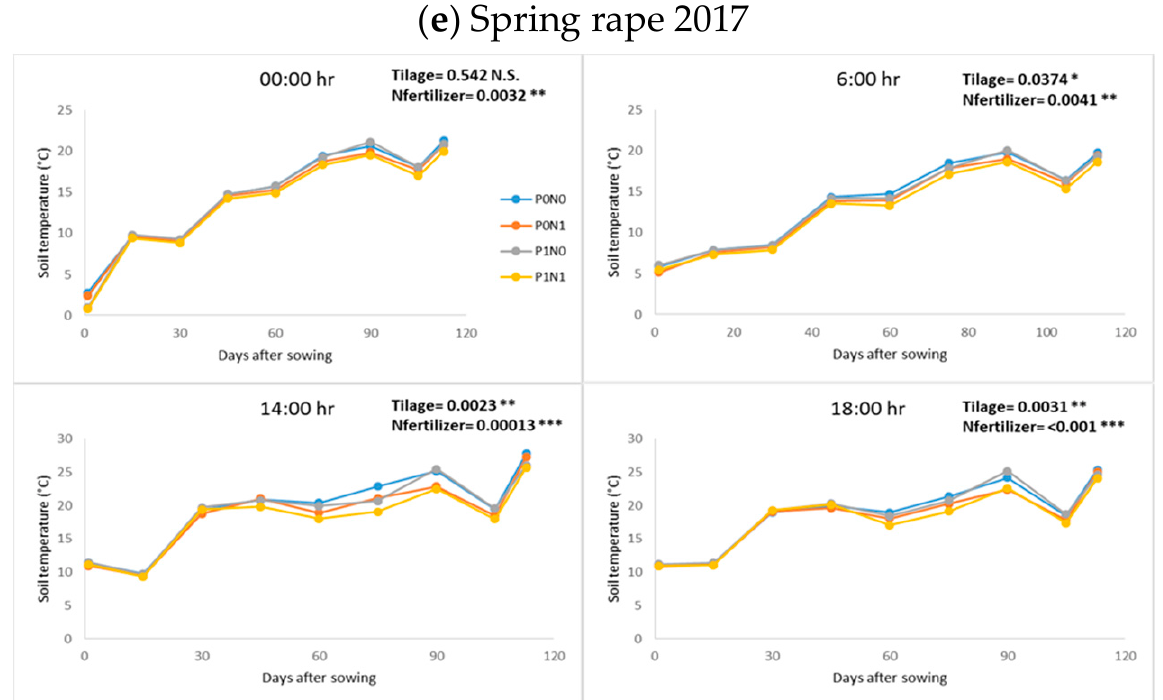
Figure 6. Soil temperature (°C) variation at 5 cm soil layer under tillage and N fertilizer practices at the 0, 6, 14, and 18 h during the days after spring rape sowing (2014). * Significant difference at the 0.05 probability level, ** significant difference at the 0.01 probability level, *** significant difference at the 0.001 probability level, N.S. not significant by least significant different test (LSD 0.05). The interactive effects of the tillage with N fertilizer practices on the T on the crop growing period during the experimental years. Irrespective of the N fertilizer